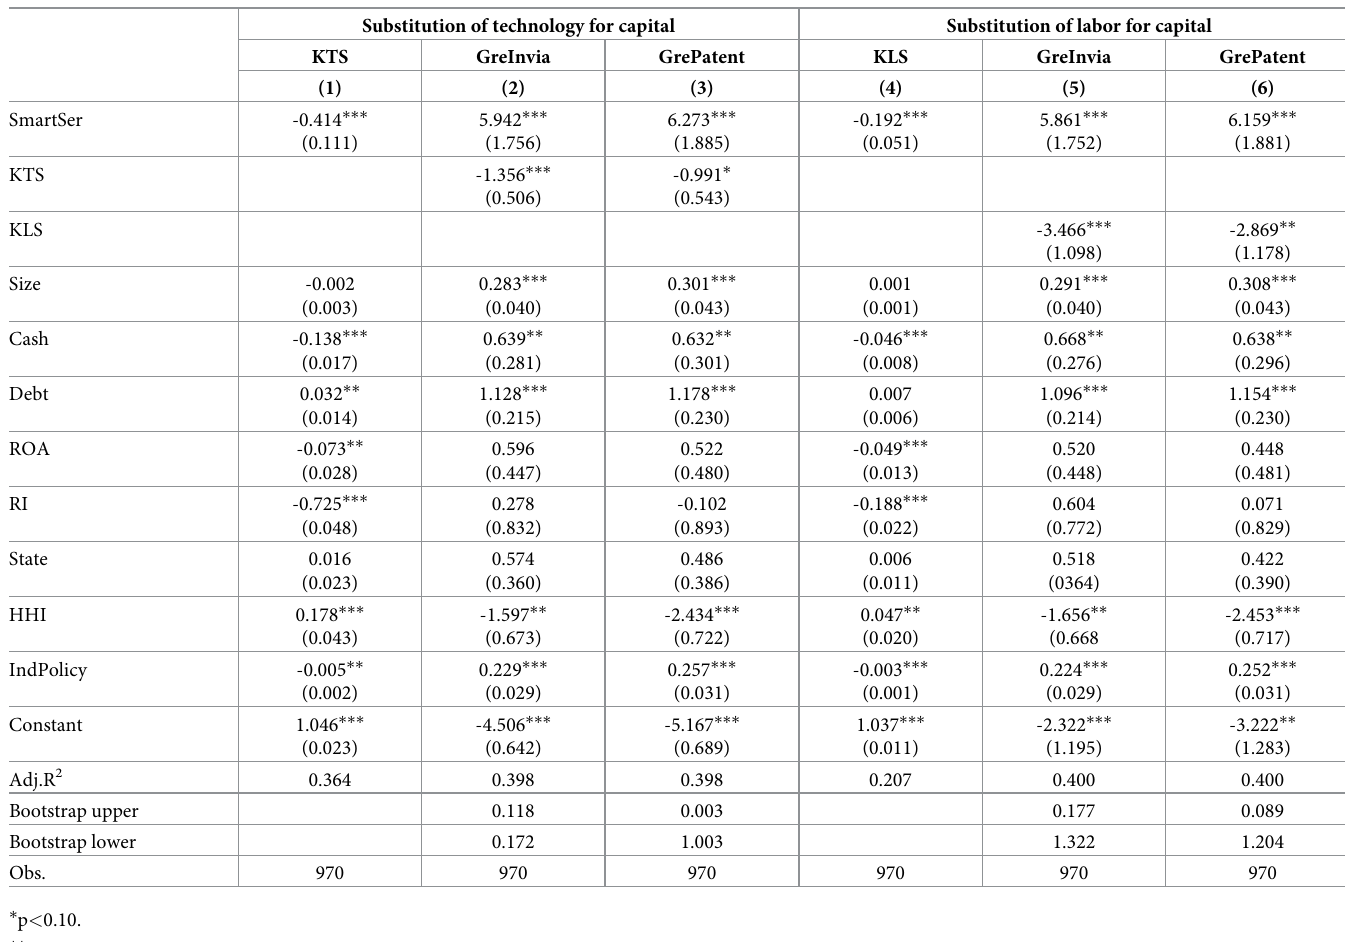
Table 7. Test results of mediating mechanism